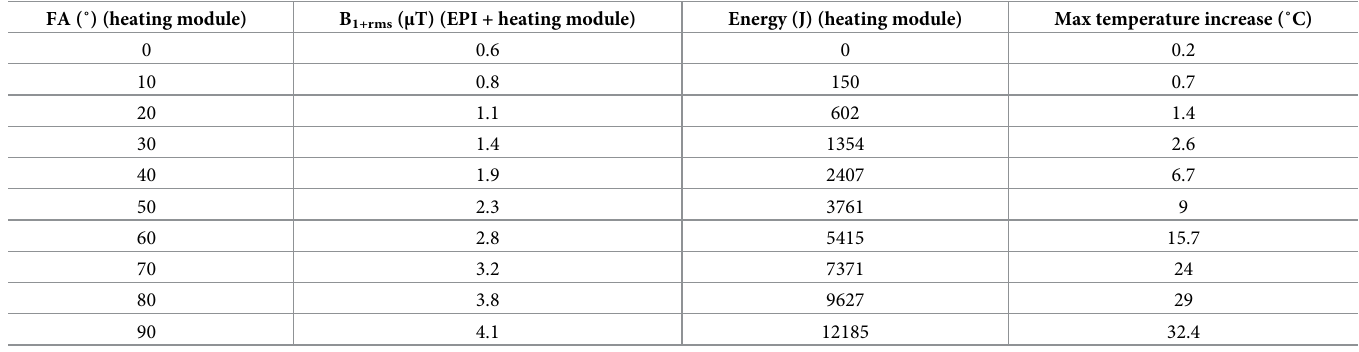
Measured B 1+rms are those provided by the scanner at the end of heating (dynamic acquisition #90). Energy values of the heating module are computed from the sequence. The last column reports the maximal temperature values measured by the proposed MRI thermometry method.